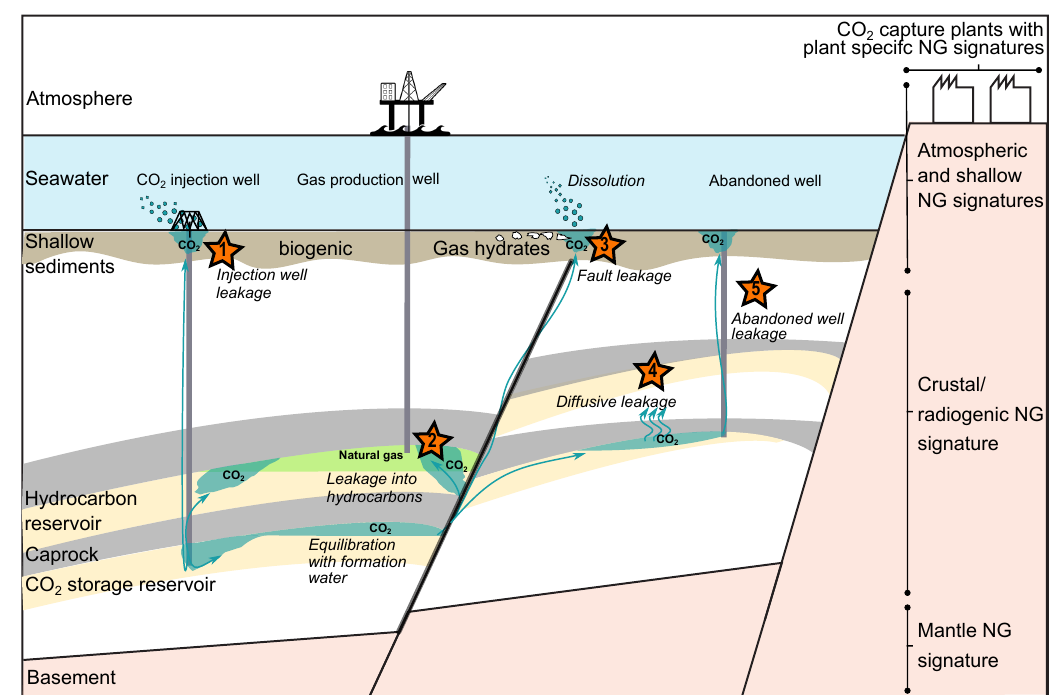
Figure 1. Overview sketch of a CO 2 storage site with areas typically attributed to a type of noble gas (NG) signature [10]. CO 2 will have a different NG signature for different plant types, such as postcombustion, natural gas processing, or oxyfuel [11,12]. Possible leakage pathways are (1) injection well leakage, (2) migration into and contamination of hydrocarbon reservoirs that may subsequently be produced, (3) fault leakage, (4) diffuse leakage, and (5) leakage through an abandoned well. Leaking CO 2 may enter the atmosphere or dissolve in